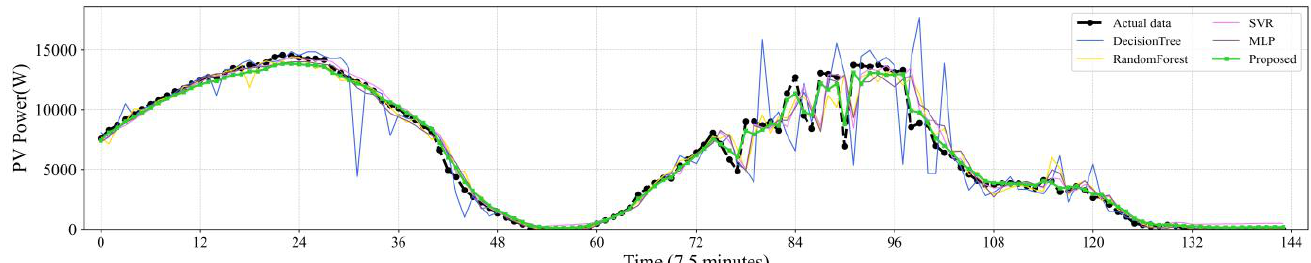
Figure 7. Contrasting the final prediction result with the actual value.